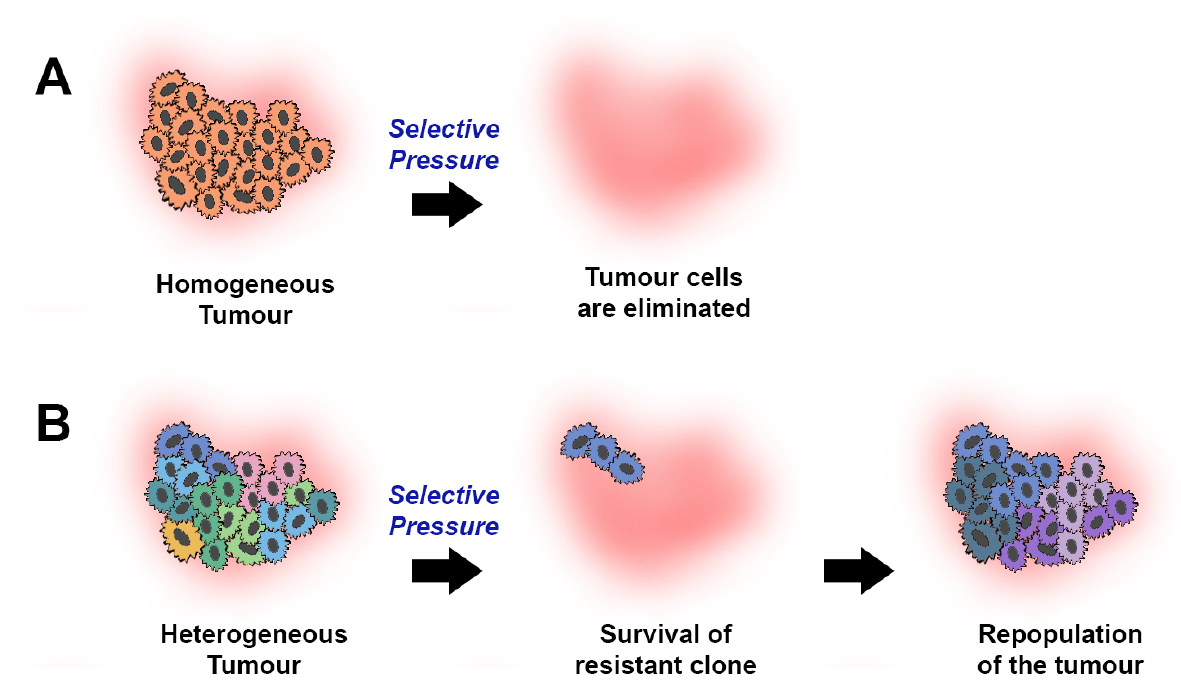
Figure 2. Intra-tumour diversity as a universal prognostic marker. A homogeneous tumour ( A ) will be eradicated in response to a selective pressure such as chemotherapy, whereas a heterogeneous tumour ( B ) is more likely to contain a pre-existing resistant clone that survives the selective pressure and seeds the repopulation of the